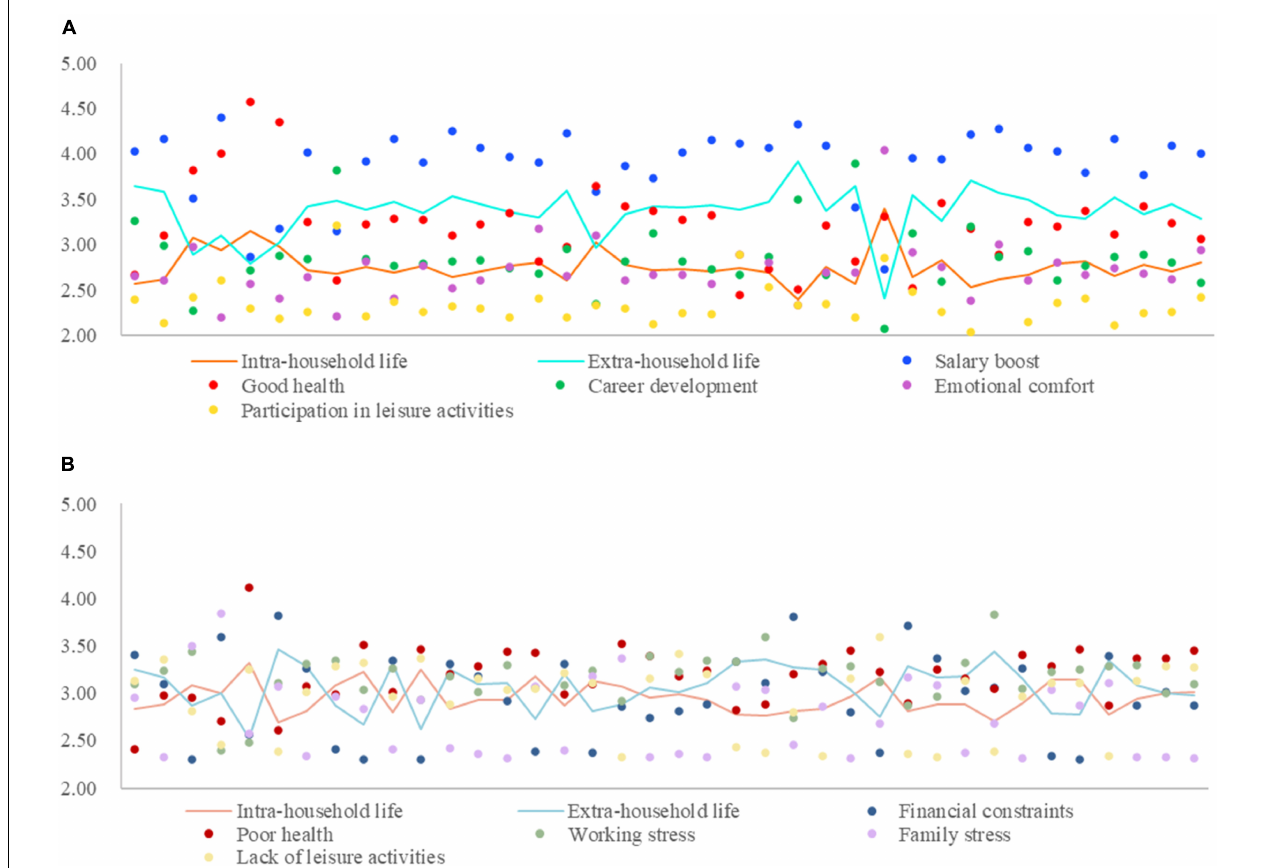
FIGURE 6 | Emotional cognition of professional females based on various attributes. (A) The sources of positive emotions. (B) The sources of negative emotions.